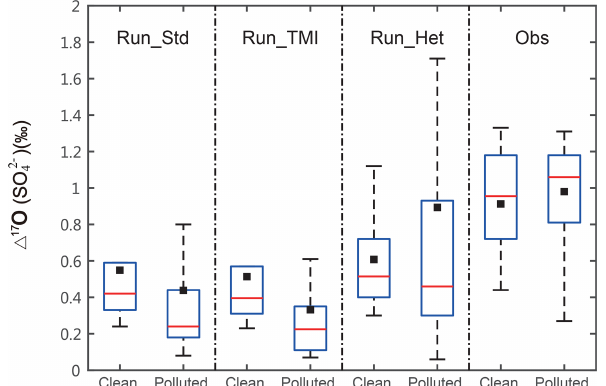
Figure 2. The box charts show observed vs. modeled (cid:49) 17 O(SO 2 − in Beijing for each model simulation, separated for heavy pollution and clean periods. The box line from bottom to top is, respectively, the percentile of 25%, 50%, and 75%; the whisker from bottom to top is, respectively, the minimum and the maximum; and the black square is mean